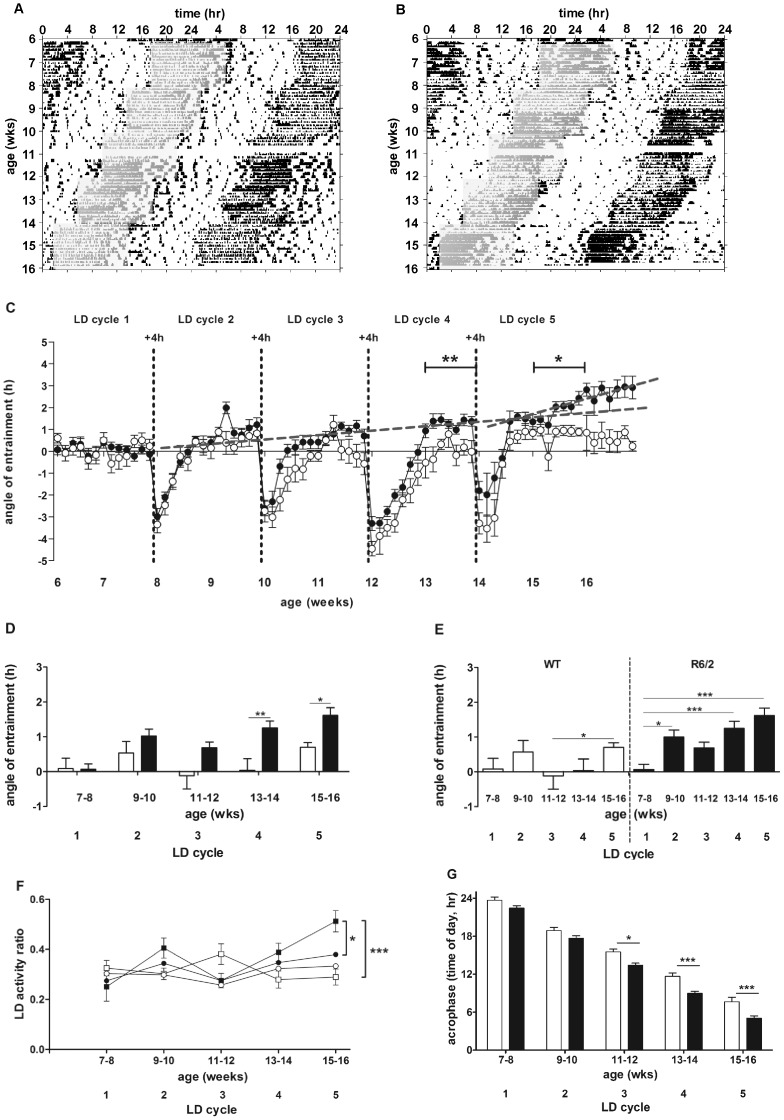
Double-plotted actograms from mice subjected to repeated 4 hour phase-advances (shaded blocks).Representative WT mice are shown in (A), and R6/2 mice in (B). Phase angles of entrainment throughout the study are shown in C. The dotted lines in C indicate linear regression in R6/2 mouse data from 8–14 weeks, and 14.5–17 weeks. Inter-genotype comparisons of angles of entrainment from the second week of each phase-advance are shown in D. E shows intra-genotype comparison of phase angles from the second week of each phase-advance. F shows the light/dark (LD) activity ratios under normal 12∶12 LD conditions (squares) and following repeated phase-advance (circles). G shows average acrophase for the second week following each phase-advance. In C-G, WT mice are shown as open symbols/columns, R6/2 mice are represented by filled symbols/columns. Data in C-G are means ± SEM. * = p<0.05, ** = p<0.01, *** = p<0.001.